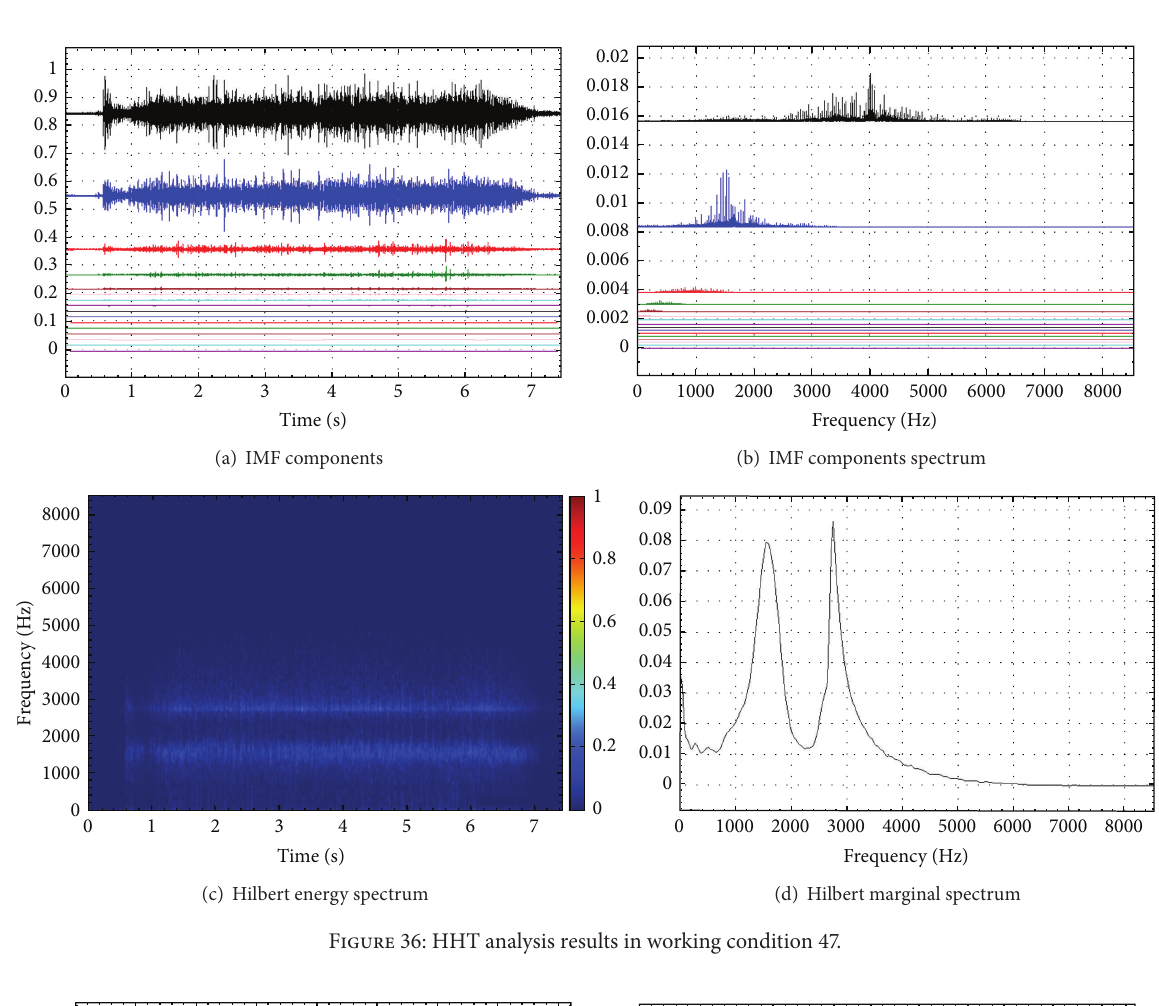
Figure 36: HHT analysis results in working condition 47.